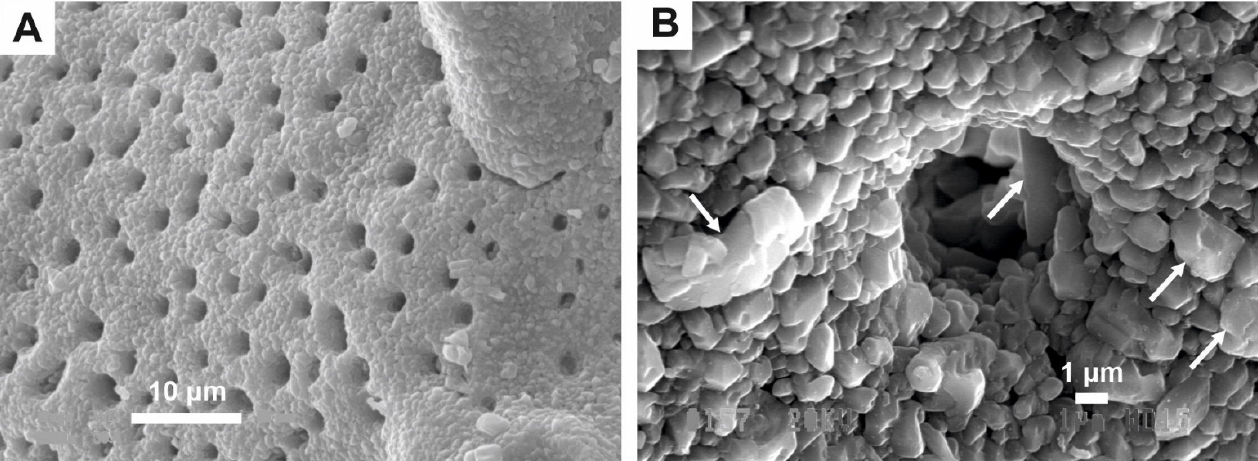
Figure 1. SEM photomicrographs of the microstructure of foraminifera tests from Campanian–Maastrichtian (Upper Cretaceous) chalk of Mielnik (Eastern Poland; cf. [77]). ( A ) Well-preserved microgranular texture of Bolivinoides giganteus foraminifera test. ( B ) Merged second-order aggregates (arrowed) indicate minor diagenetic alteration of Gavelinella sp. foraminifera test.